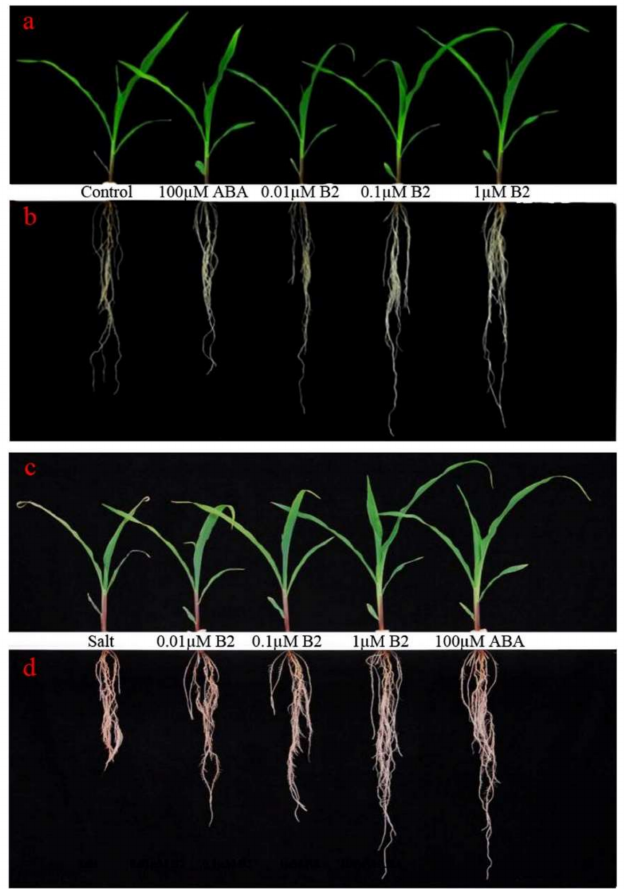
Figure 2. The morphology of maize seedlings. ( a , b ) The maize seedlings in normal solution treated with 100 µ M ABA or 0.01 µ M, 0.1 µ M, or 1 µ M B2 after 6 days. ( c , d ) The maize seedlings under salt stress conditions treated with ABA or B2 after 6 days. The seedlings are arranged from small to large from left to